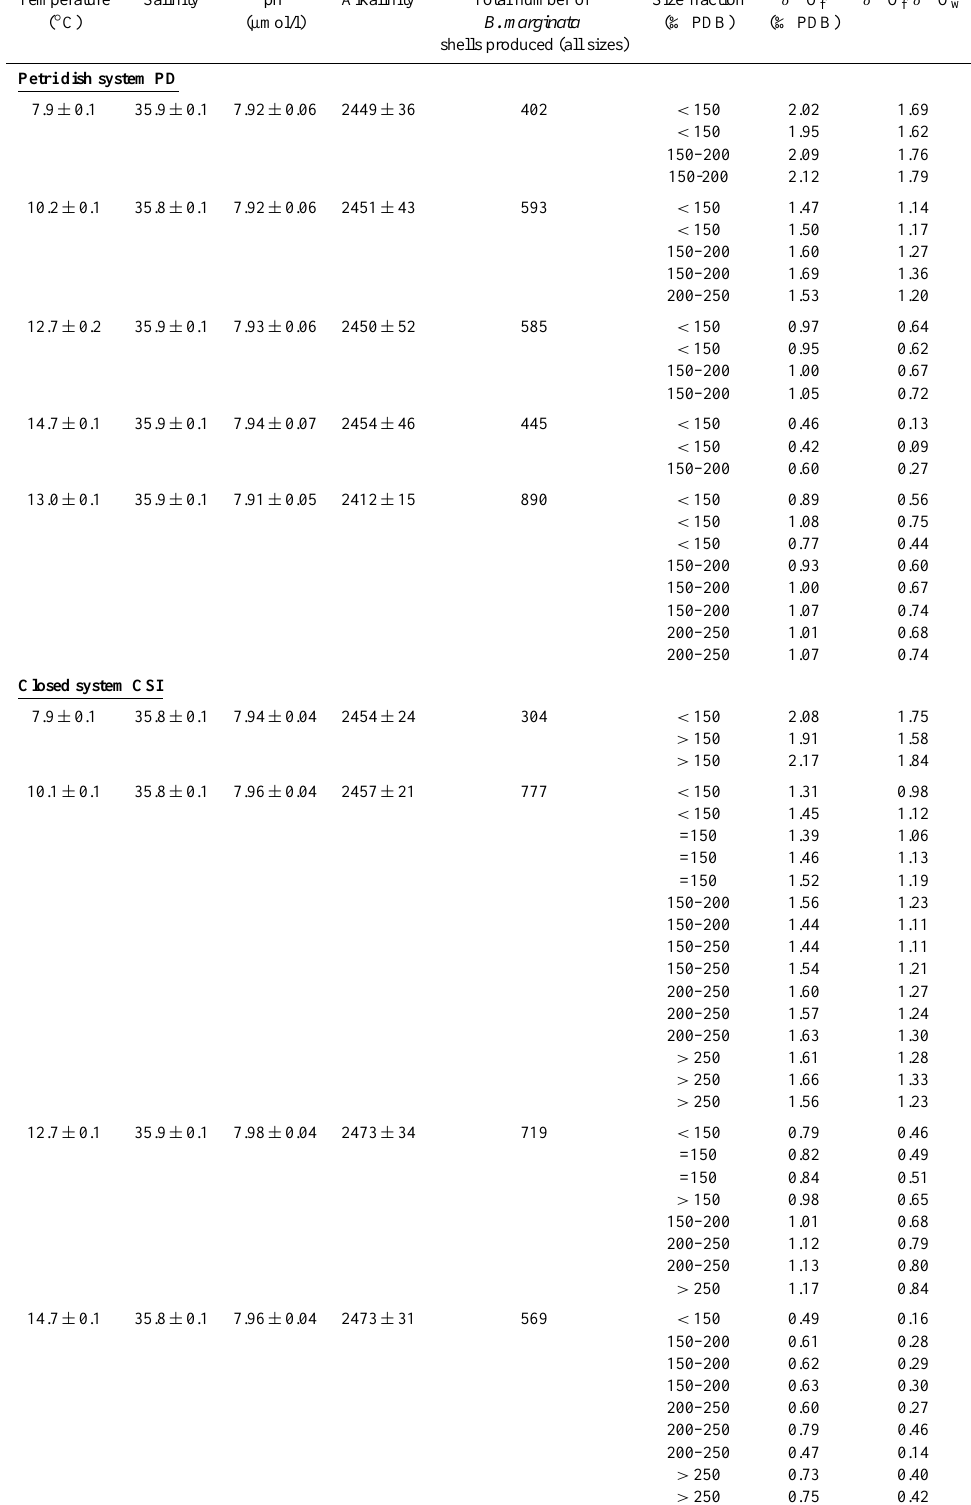
Table 1. Physico-chemical parameters (temperature, salinity, pH and alkalinity) measured during PD, CSI and CSII experiments, total number of B. marginata shells entirely calcified under controlled conditions per experimental temperature, and δ 18 O composition of the shells according to different size